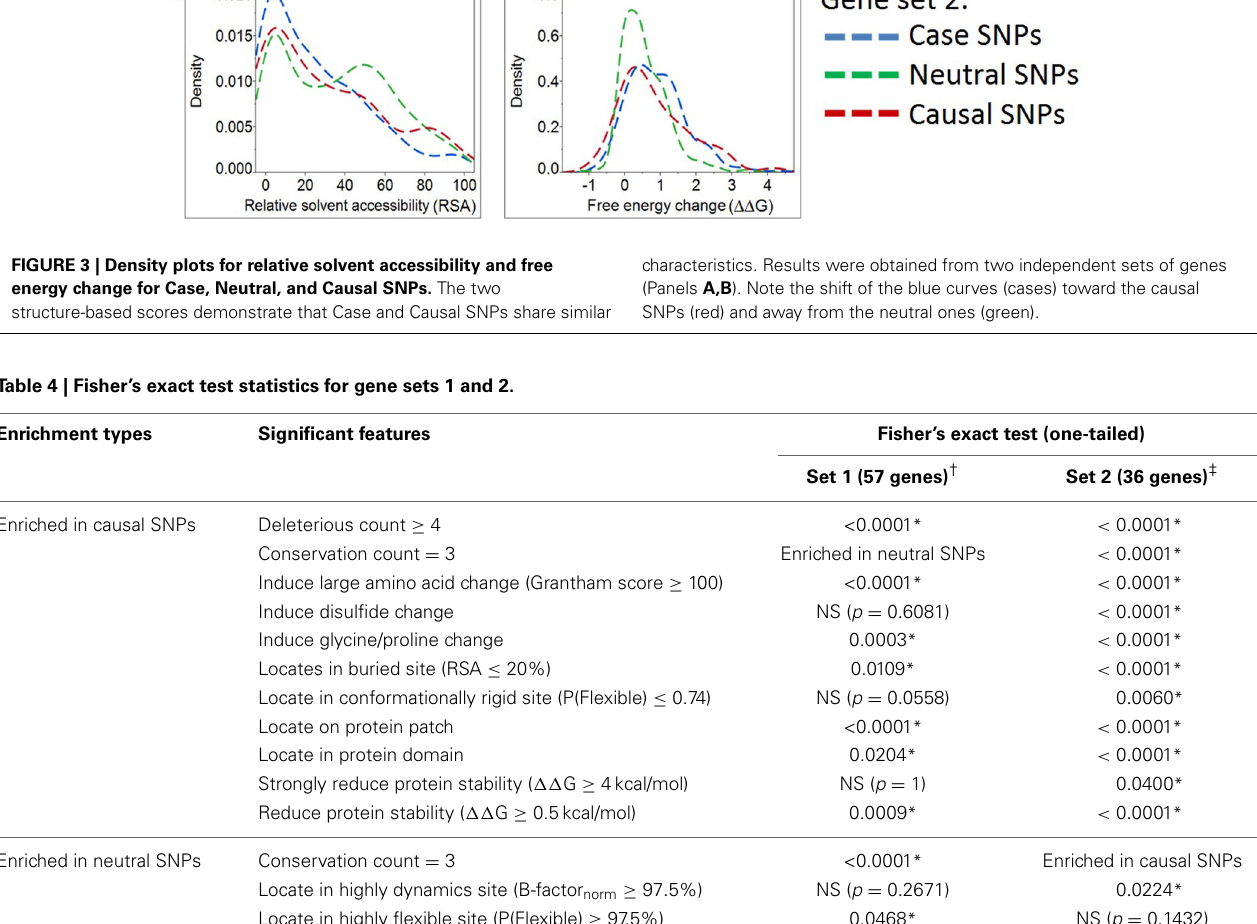
characteristics. Results were obtained from two independent sets of genes (Panels A,B ). Note the shift of the blue curves (cases) toward the causal SNPs (red) and away from the neutral ones (green).